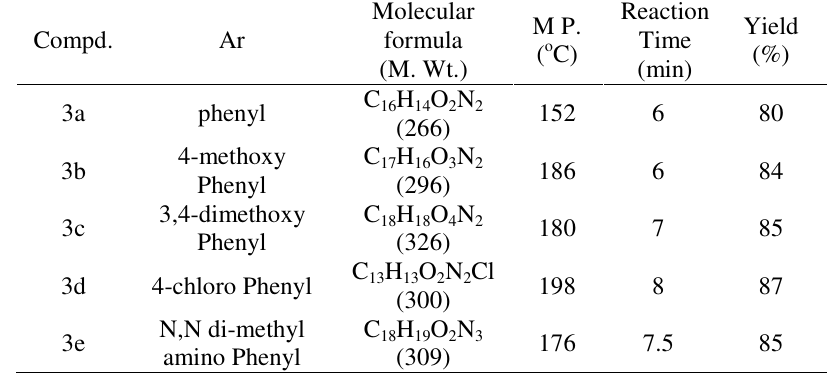
Table 1. Physical data of some 3-(2’-hydroxyphenyl)-5-(substituted aryl)-2-pyrazoline-N 1 - caboxaldahydes Compd.